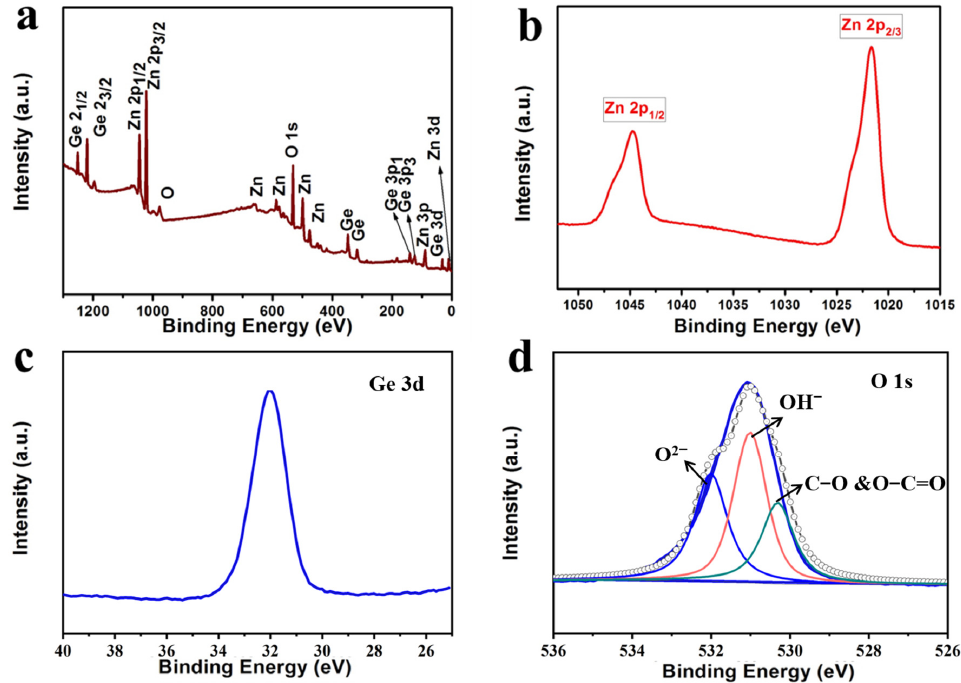
Figure 3. XPS spectra of Zn 2 GeO 4 -150: ( a ) survey spectrum, ( b ) Zn 2p peak, ( c ) Ge 3d peak, ( d ) O 1s peak.